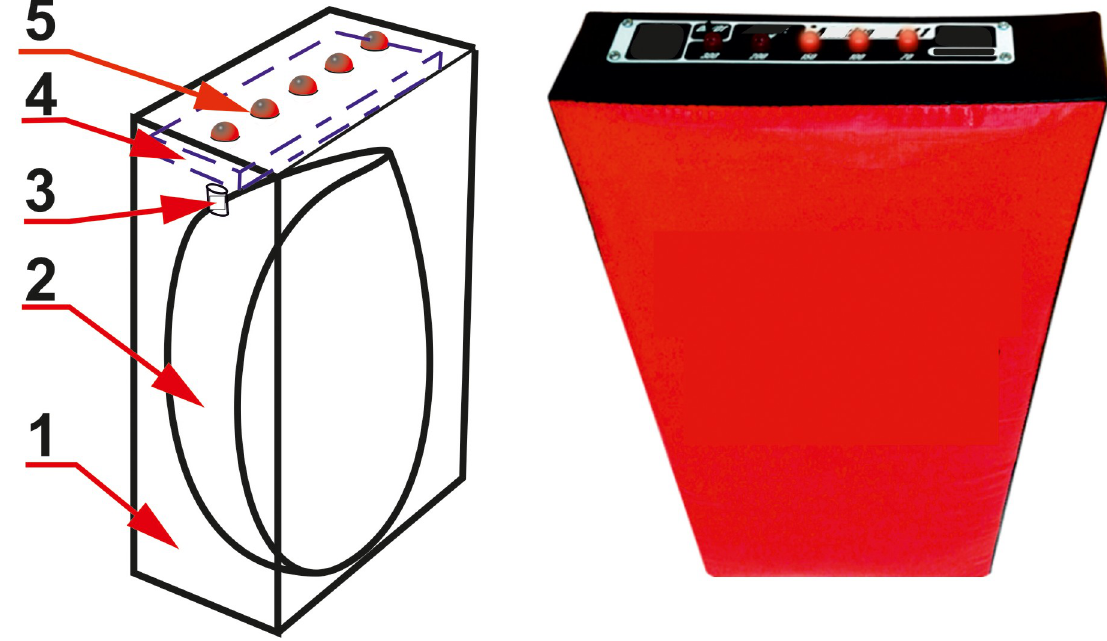
Fig 2. Photo and schematic diagram of a punching pad. 1—housing, 2—air camera, 3—air pressure sensor, 4—microcontroller control unit with Bluetooth module, 5—LEDs.